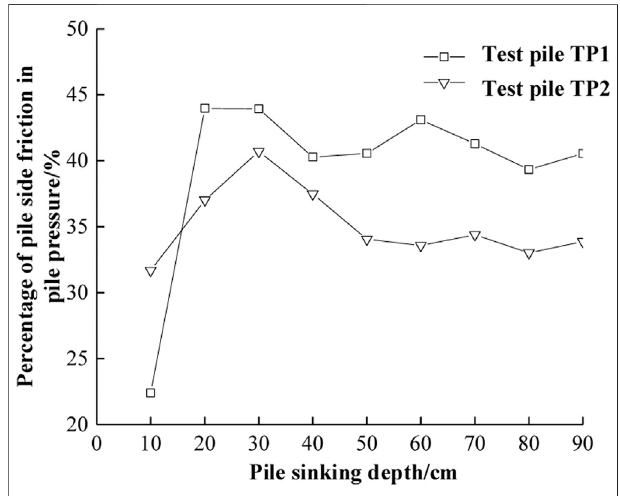
FIGURE 11 | The side resistance of the pile as a percentage of the pile